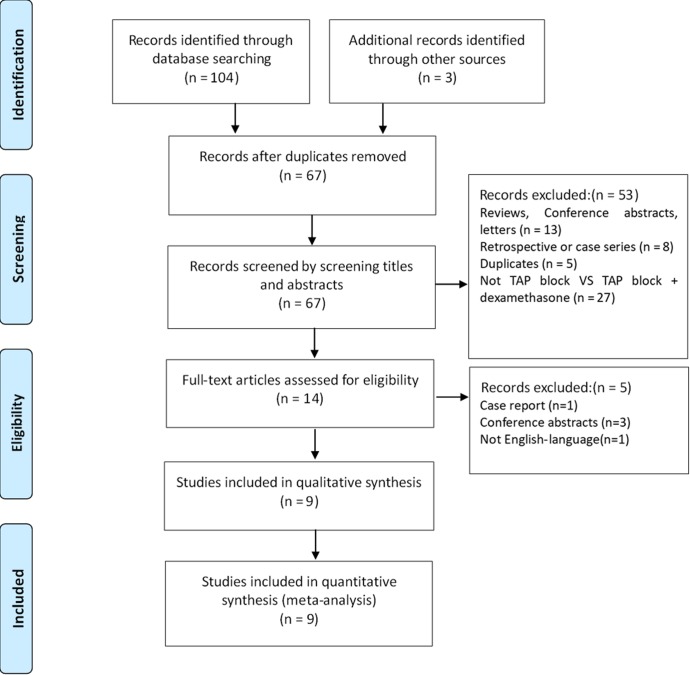
The flow diagram of study selection.